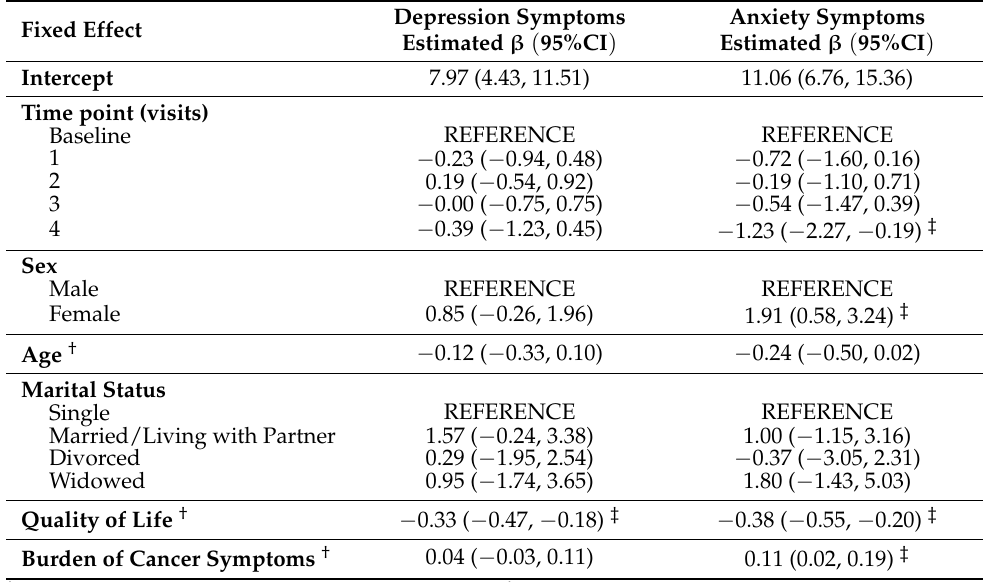
Table 3. Mixed linear regression models of HAD scale scores for depression and anxiety among individuals with cancer diagnosis receiving treatment (n =